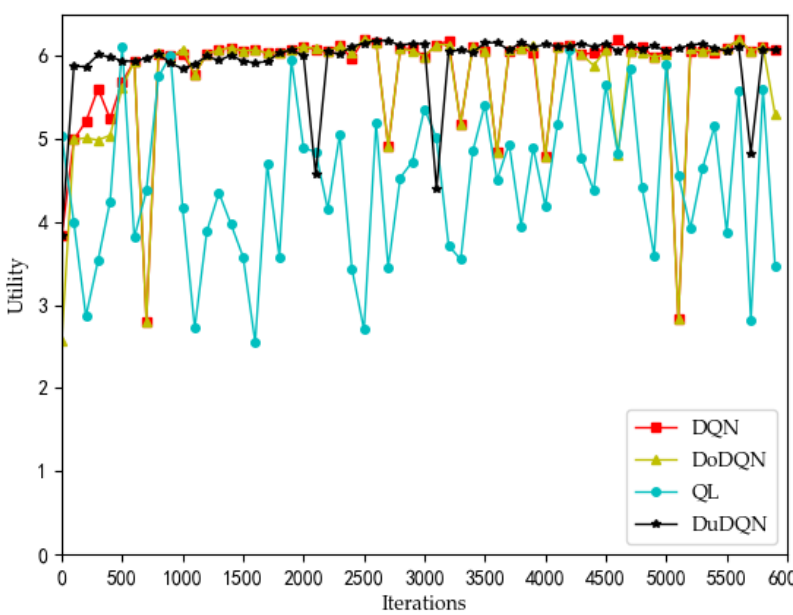
Figure 11. Comparison of utility using different methods (taking MVNO-1 as examples).